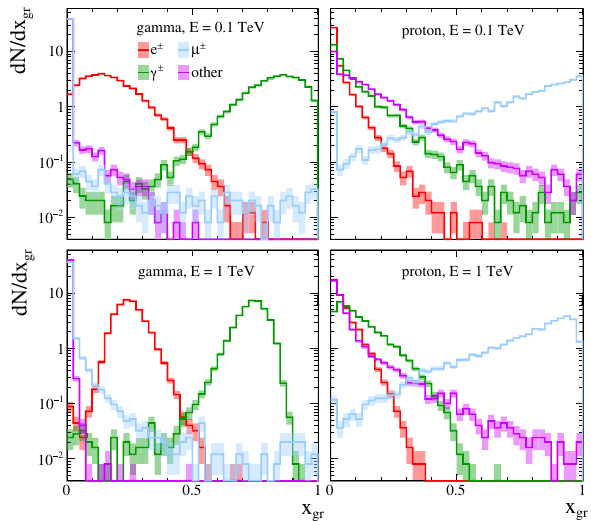
Fig. 1 Distribution of the fraction x gr = E i / E gr of the total energy that reaches ground E gr per particle type i = ( e ± ,μ ± ,γ or other) for vertical EASs with a ground altitude of 5 km above sea level. The left panelsshowthedistributionsfor γ -rayprimarieswhileprotonprimaries are shown in the right panels. Top and bottom panels correspond to 100 GeV and 1 TeV primary energy